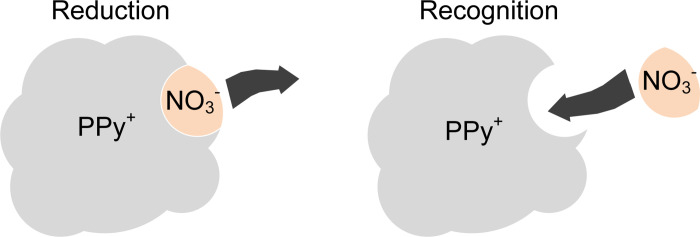
PPy-NO3- membrane for selective recognition of NO3-.